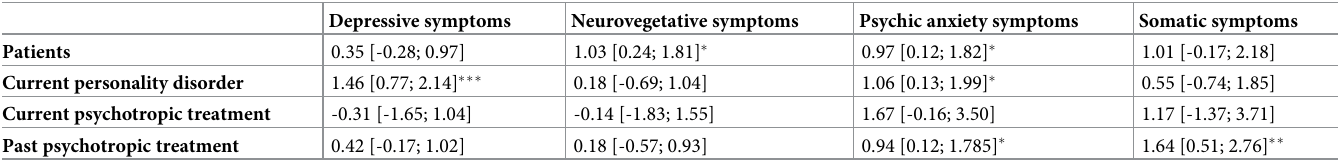
Table 2. Associated factors with symptom scores in all participants.